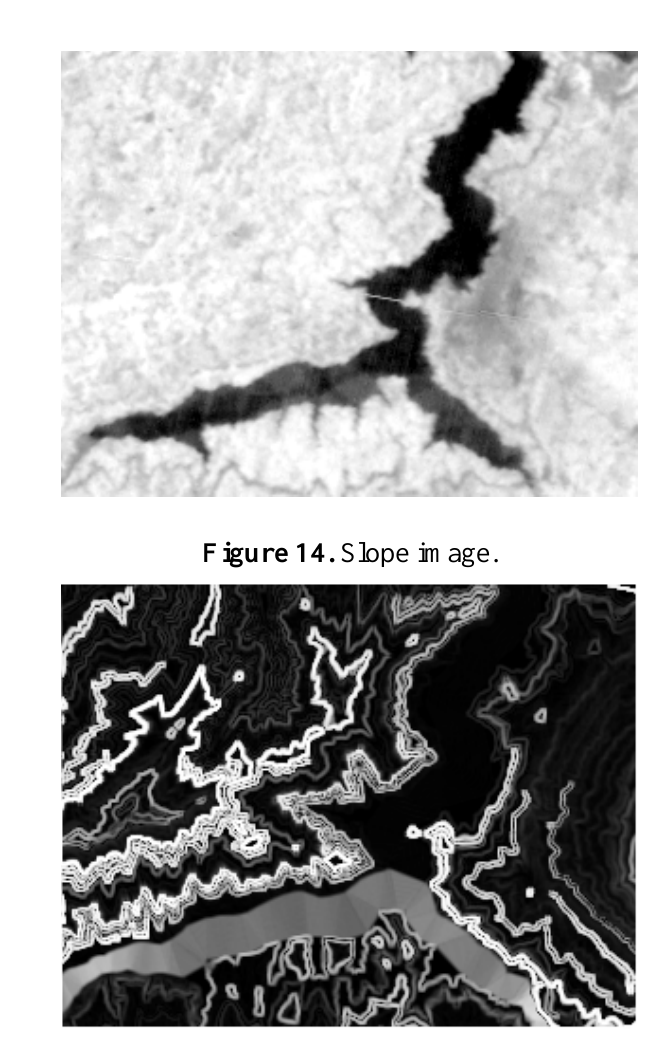
Figure 13. NDVI image.